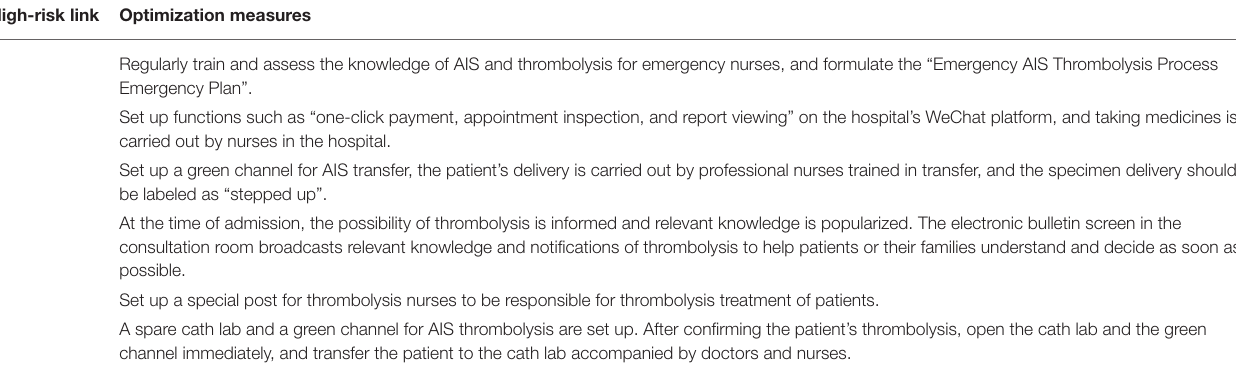
TABLE 3 | Corresponding optimization measures for each high-risk link of AIS